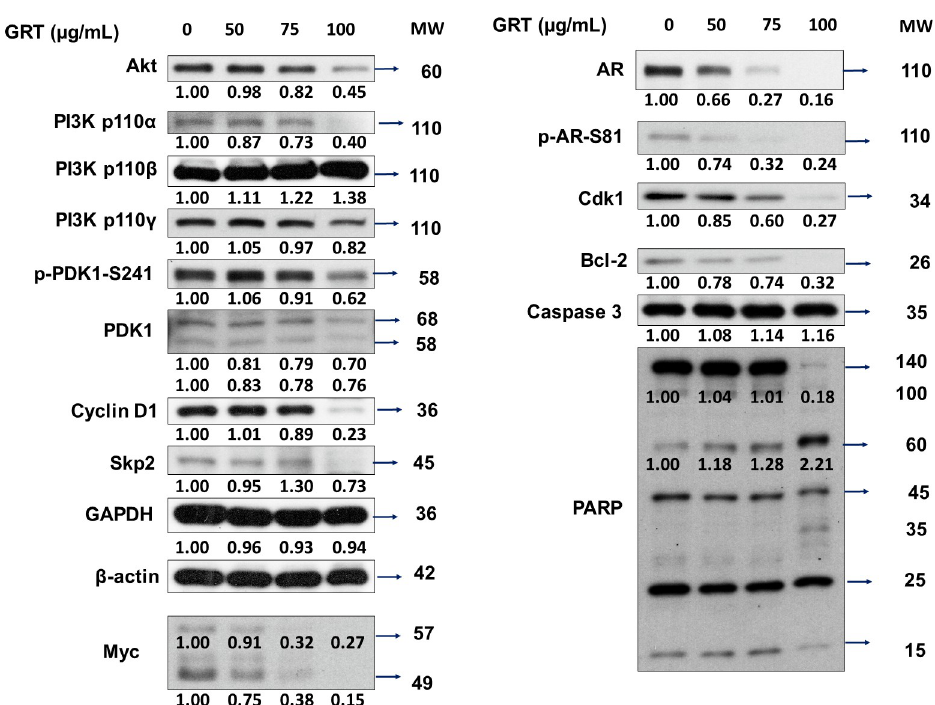
Fig 4. Western blotting analysis of signaling proteins affected by GRT treatment in C4-2 MDV3100r cells. The C4-2 MDV3100r cells were treated with increasing concentrations of GRT (0, 50, 75, and 100 μ g/mL) for 48 h. Expression of Akt, PI3K p110 α , PI3K p110 β , PI3K p110 γ , PDK1, phospho-PDK1 (S241), Skp2, cyclin D1, AR, phospho-AR (S81), Cdk1, Myc, Bcl-2, caspase 3 and PARP proteins were determined by Western blotting. Expression level of GAPDH and β -Actin were used as loading